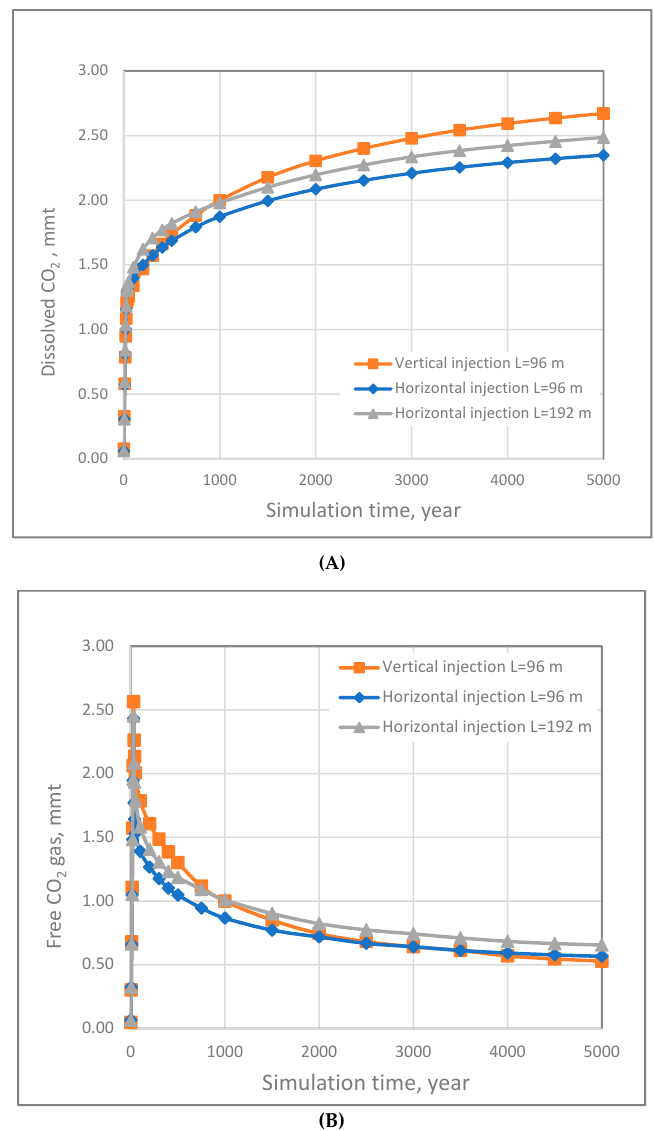
Figure 14. ( A ). Effect of injection orientation for cases 10, 11 and 12 (Table 3) on CO 2 solubility in a homogeneous domain. ( B ). Effect of injection orientation for cases 10, 11 and 12 (Table 3) on free ‐ gas CO 2 in a homogeneous domain.